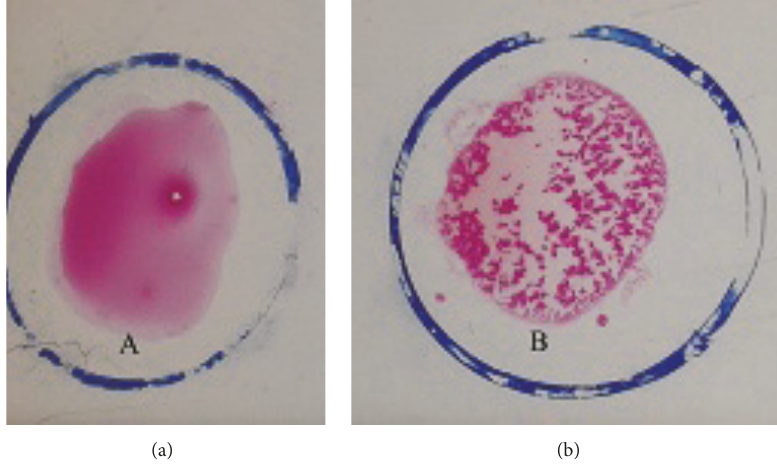
Figure 1: RBPT negative (a), RBPT positive